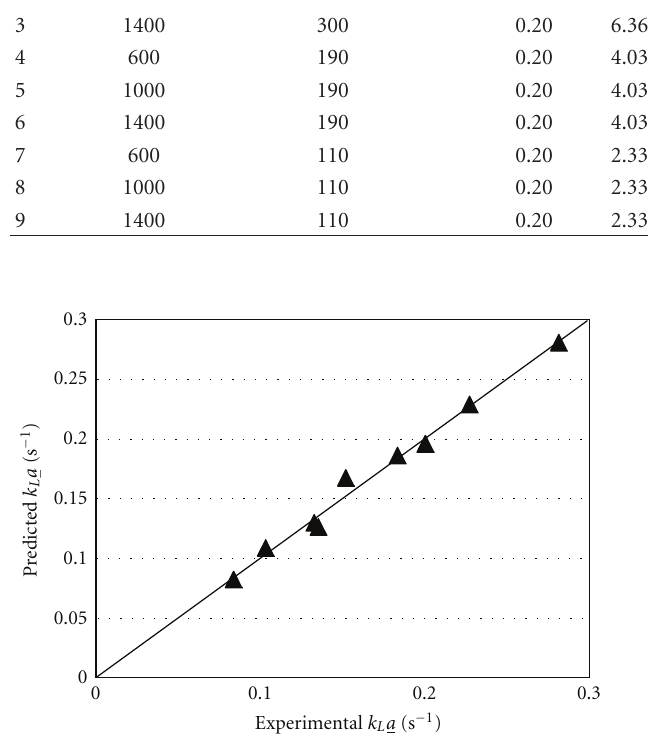
Figure 8: Parity plot of overall mass transfer coe ffi cient prediction from proposed correlation with experimental data of Dehkordi [1, 2].